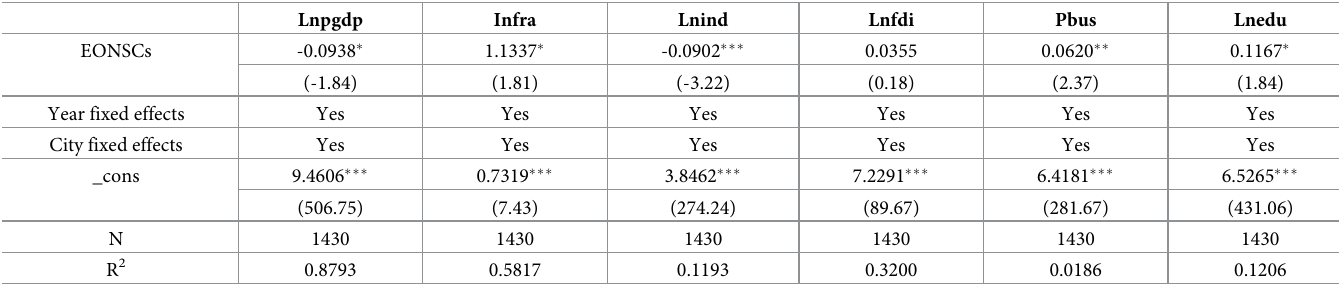
Table 8. Mechanisms screening of the impact of the EONSCs campaign on environmental governance